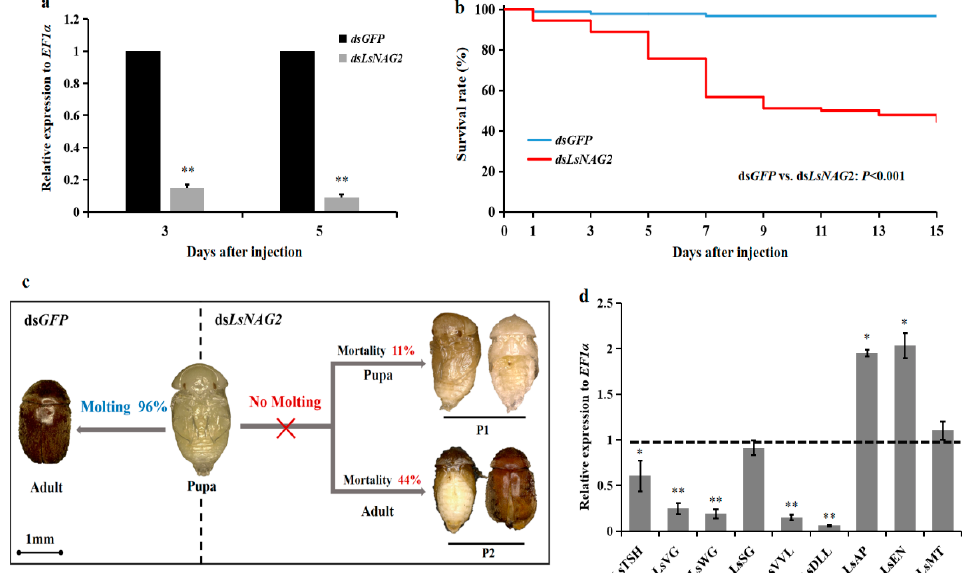
Figure 5. E ff ect of LsNAG2 RNAi on the pupal–adult transition in L. serricorne . ( a ) Relative expression levels of LsNAG2 at 3 and 5 days after the LsNAG2 or GFP dsRNA injection at day 5 of pupae. ( b ) Changes in survival of L. serricorne pupae after LsNAG2 or GFP dsRNA injection. ( c ) Representative phenotypes of the pupae after LsNAG2 or GFP dsRNA injection. Injection of ds LsNAG2 resulted in two lethal phenotypes. P1: pupae were unable to shed o ff their old cuticles and died without completing adult eclosion; P2: pupae molted to adults but died with an asymmetric wing pattern. Pupae were alive and successfully molted to adults at day 3 after injection with ds GFP . ( d ) E ff ects of LsNAG2 knockdown on the expression of genes involved in wing development. The expression levels of wing development-related genes in the control is marked with a dashed line. Significant di ff erences between treatment and control with Student’s t -test are indicted by * p < 0.05, ** p <